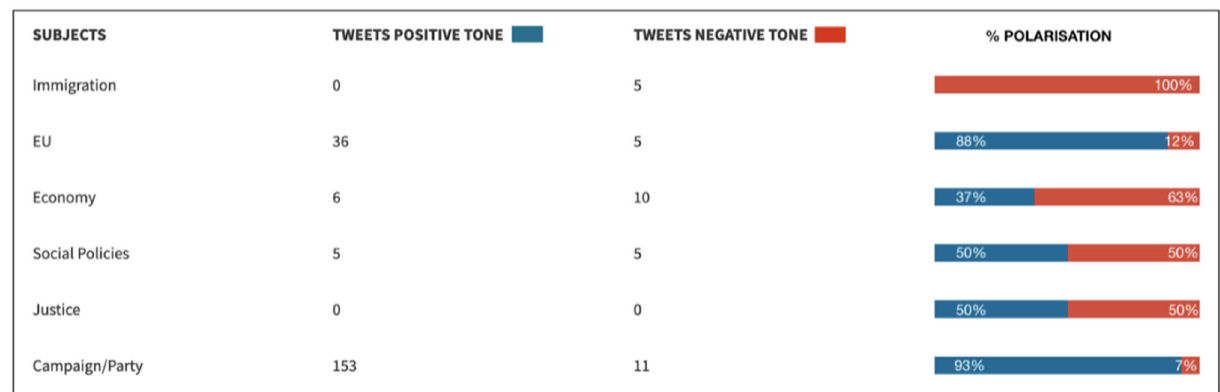
Fig. 7 Evaluation of the tone in which each theme is narrated (2014)/Own elaboration.